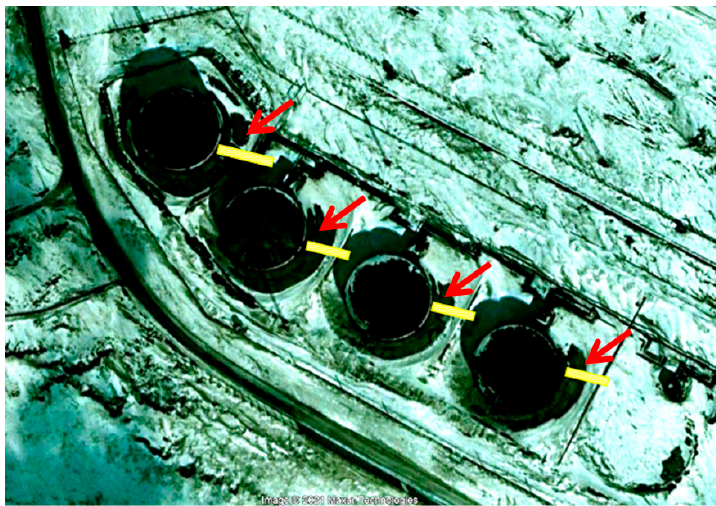
Figure 13. Google Earth image of oil tanks in early spring. Yellow strips mark the location of virtual horizontal plates of dihedrals (OB in Figure 3). Red arrows mark snow free patches near the tanks.